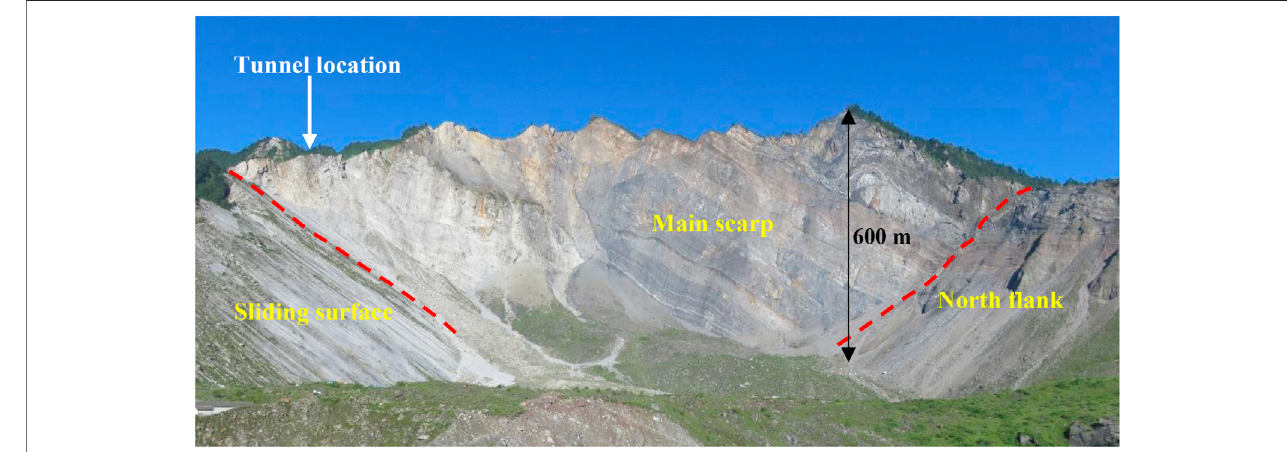
FIGURE 2 | The source area of the DGB landslide.